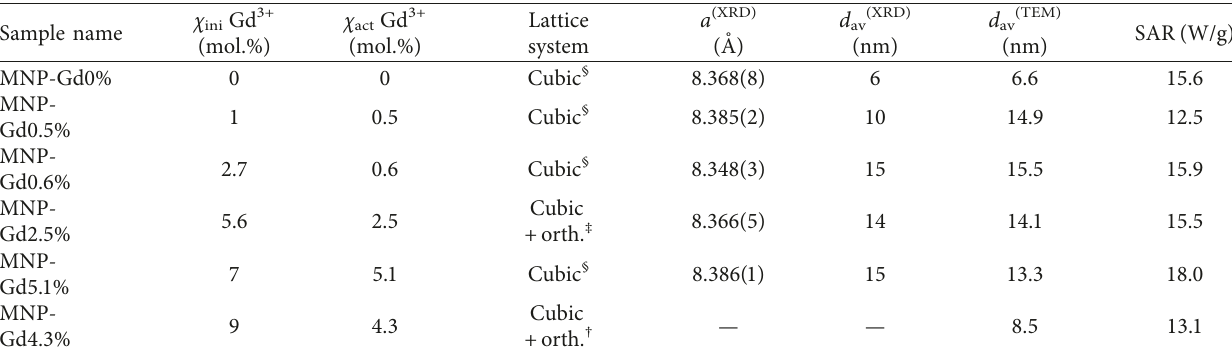
Table 1: Properties of synthesized MNPs: initial loading ( χ lattice parameter ( a ), and average crystallite size of MNPs ( d av ) calculated from XRD and TEM data, and SAR values evaluated after the hyperthermia test.